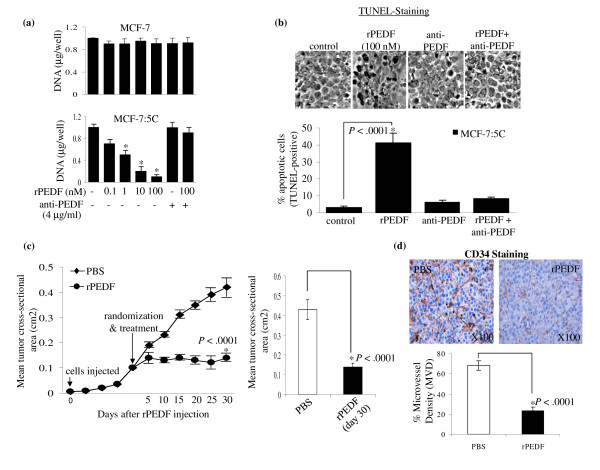
Effect of recombinant pigment epithelium-derived factor (rPEDF) on the growth of endocrine-sensitive MCF-7 and endocrine-resistant MCF-7:5C breast cancer cells in vitro and in vivo. (a) MCF-7 and MCF-7:5C cells were treated with increasing concentrations of rPEDF, rPEDF + anti-PEDF antibody (anti-PEDF), or anti-PEDF antibody for 7 days, and cell proliferation was determined using a DNA quantitation kit as described in Materials and methods. Experiments were repeated three times, and data are shown as mean ± standard deviation (SD). *P < 0.001 compared with untreated controls. (b) MCF-7:5C cells were treated with rPEDF, anti-rPEDF, or rPEDF + anti-rPEDF for 72 hours and apoptosis was determined by TUNEL staining. Bar graph: summary of percentage of apoptotic cells counted in five fields from three experiments. Data presented as mean ± SD. (c) Effect of rPEDF on the growth of MCF-7:5C cells in vivo. MCF-7:5C cells were bilaterally injected into the mammary fat pad of ovariectomized nude mice, and when tumors reached an area of 0.1 cm2 the mice (n = 15/group) were randomized into two treatment groups: PBS or rPEDF. The mean cross-sectional tumor area was measured up to 30 days. Bar graph: mean cross-sectional tumor area in the control group and the PEDF-treated group. (d) Intratumoral microvessel density (MVD) in tumor tissues was determined by immunohistochemical staining by an endothelial-specific antibody CD34; PBS group (×200) and PEDF group (×200). Quantitative analysis of microvessel density is also shown. Data presented as mean ± SD.